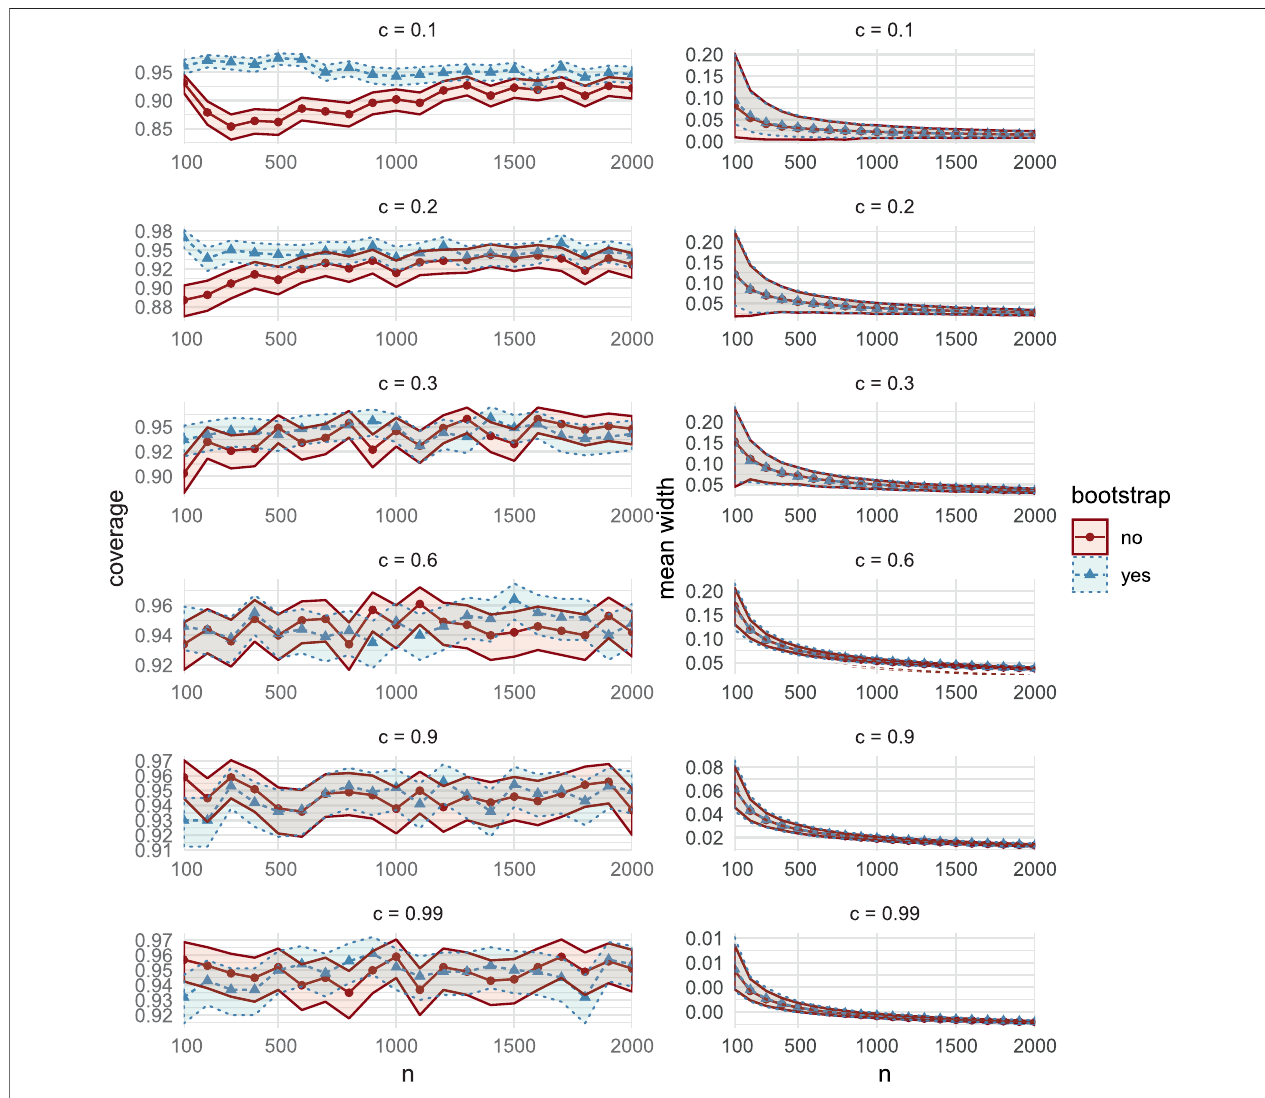
FIGURE 14 | Comparisons of coverage (left column) and mean width (right column) , between the bootstrap CIs (dashed lines with triangular markers) and the asymptotic CIs (solid lines with circular markers) in MC Study B. Rows represent correlations c, increasing from 0:1 on the top row to 0:99 on the bottom row. The horizontal axes display the sample sizes n (cid:2) 100;